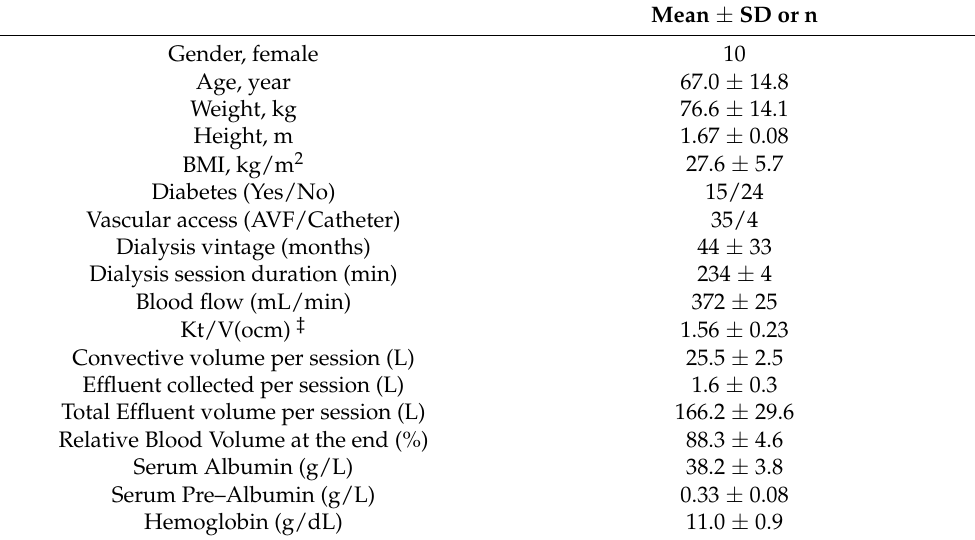
Table 1. Baseline characteristics of hemodialysis patients (N = 39).